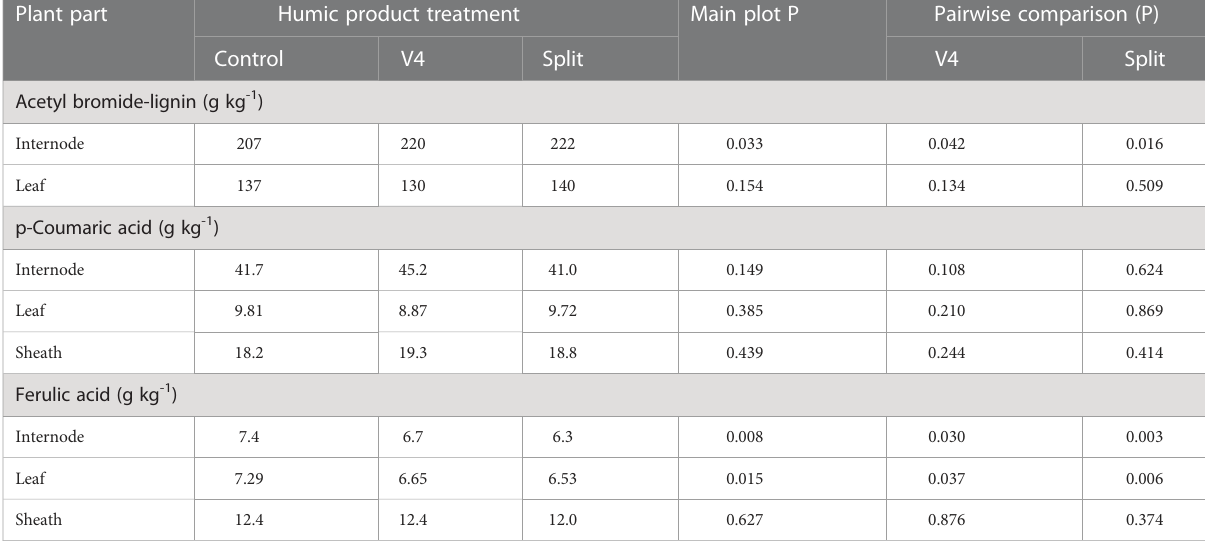
TABLE 8 Concentrations of acetylbromide-extractable lignin for the maize internode and leafimmediately above theprimaryear,and extractablep- coumaric acidand ferulic acid forthe same internode, leaf, and also accompanyingsheath,sampled from thecontrol and the V4 and split applications of thehumic productin the2013 upland transectatthe milk reproductive growth stage, together with thesigni fi cance (P) of thehumic productmain plot effect and the signi fi cances forpairwise comparisonsof theV4 and split humicproduct applications with thecontrol. Plant